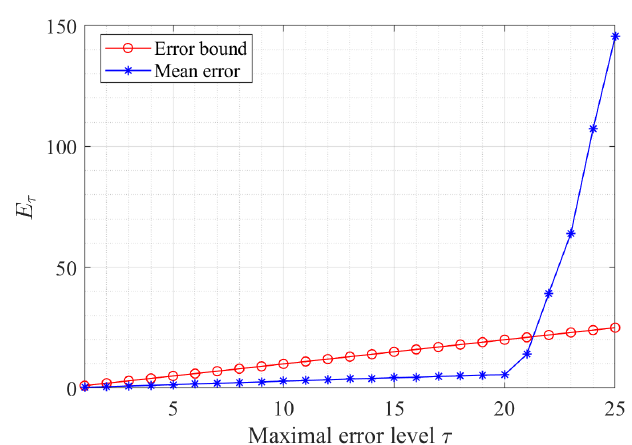
Figure 3. Estimation errors versus the maximal error level.